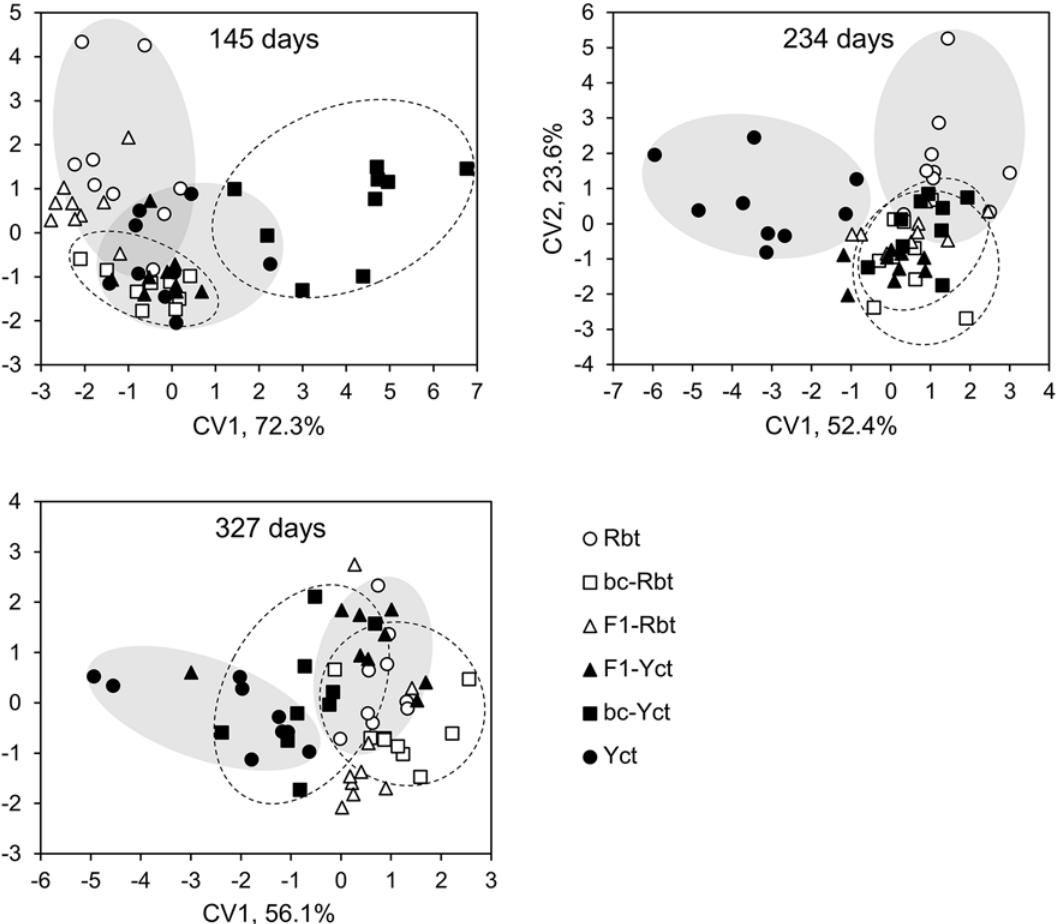
Fig 2. Canonical variates from the discriminant function analysis across eight muscle growth-related genes. Canonical variates for each individual and the percent variation on the first (CV1) and second axes (CV2) at 145, 234, and 327 days post-fertilization is shown. Rbt = rainbow trout, bc-Rbt = first generation Rbt backcross, F1-Rbt = F1 hybrid with Rbt maternal lineage, Yct = Yellowstone cutthroat trout, bc-Yct = first generation Yct backcross, and F1-Yct = F1 hybrid with Yct maternal lineage. Grey shaded ellipses indicate the spread of Rbt and Yct; stippled ellipses indicate the spread of bc-Rbt and bc-